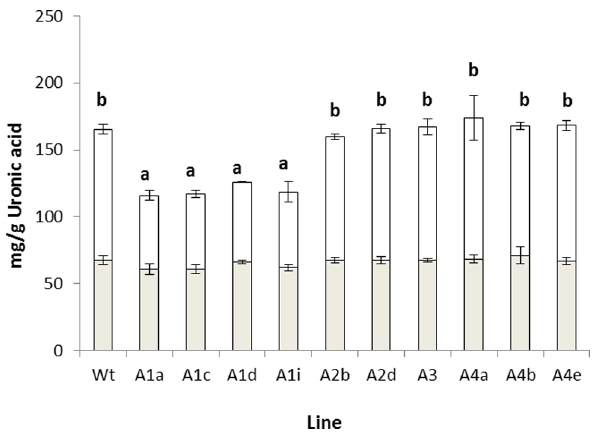
Figure 2. Pectin levels (as estimated by uronic acid content) in stem tissue from wild type and rabA knockout lines. Acetone insoluble solids were sequentially extracted with CDTA and Na 2 CO 3 to generate ionically (clear) and covalently (grey) bound pectin, respec- tively represented to show individual levels and additive total pectin. Significance values are as follows; (p , 0.001 (d.f,32 v.r,39.13) with letters